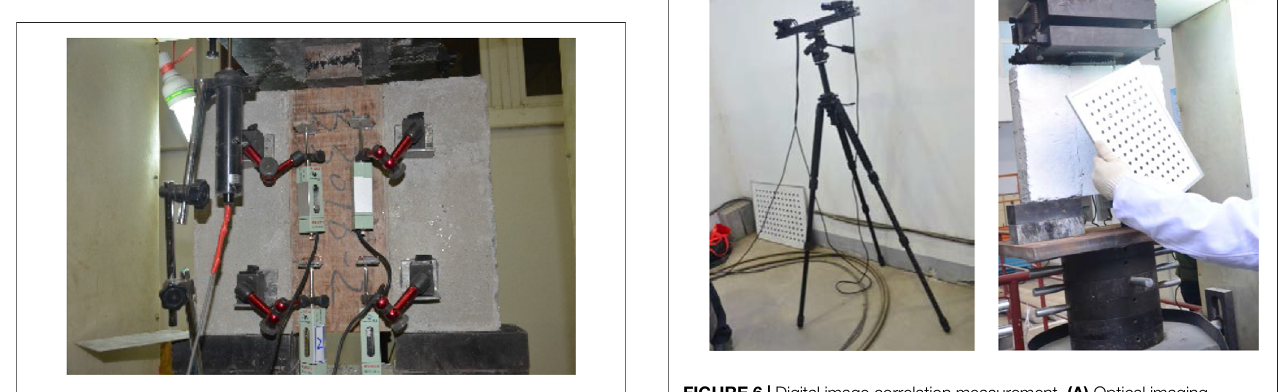
FIGURE 5 | Linear variable displacement